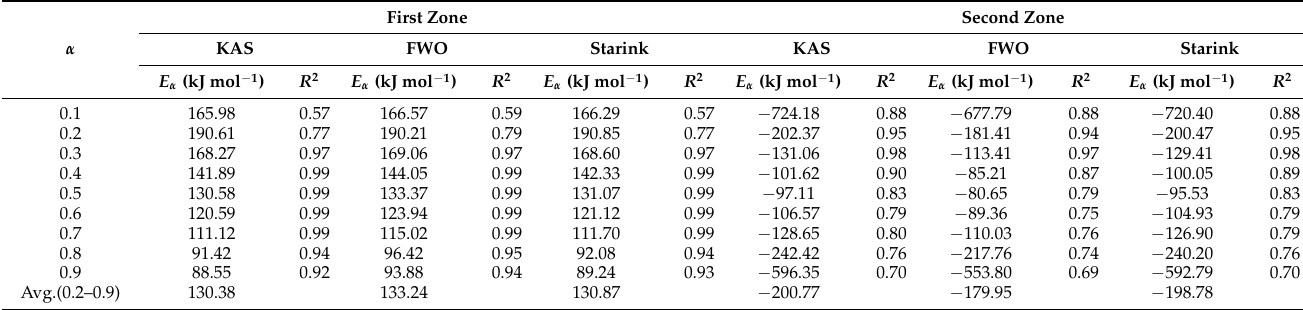
Table 6. Activation energy ( E α ) obtained by model-free methods for WPCBs.